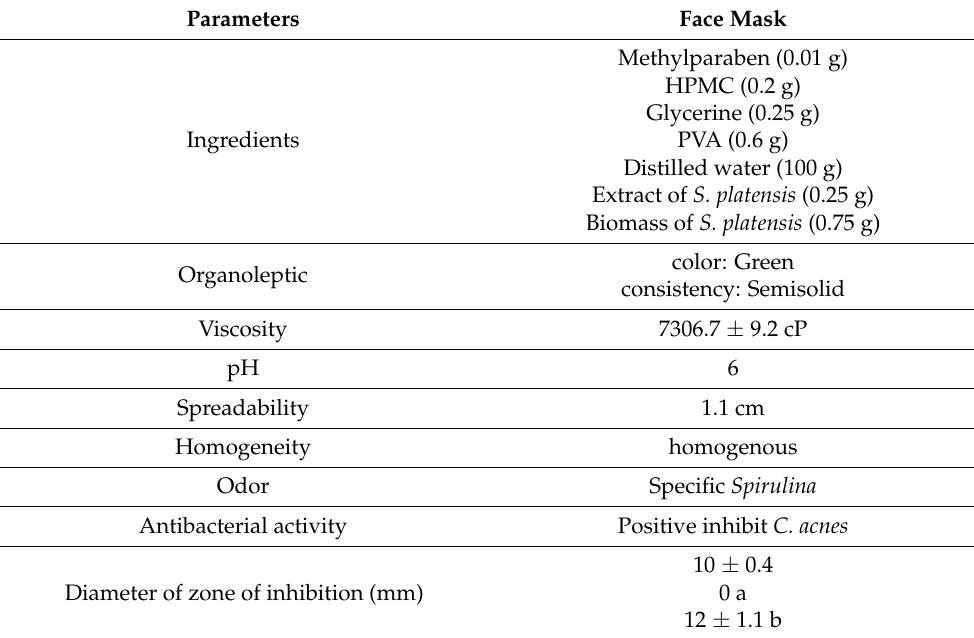
Table 6. Composition, characteristic and activity of antiacne face mask. Published by Ref.